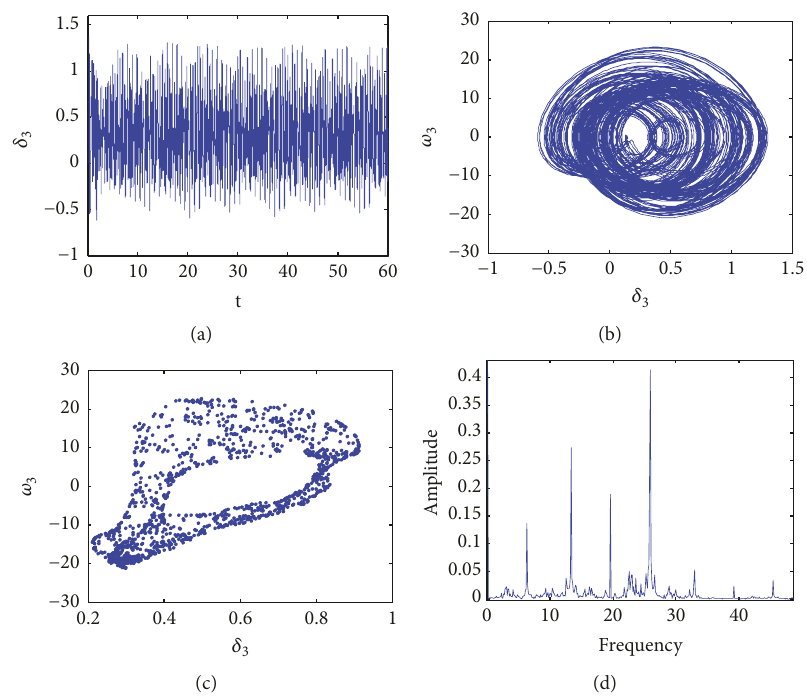
Figure 21: Chaotic motion ( 𝑉 𝐵1 = 0.78). (a) Time history. (b) Phase portrait. (c) Poincar´e map. (d) Frequency